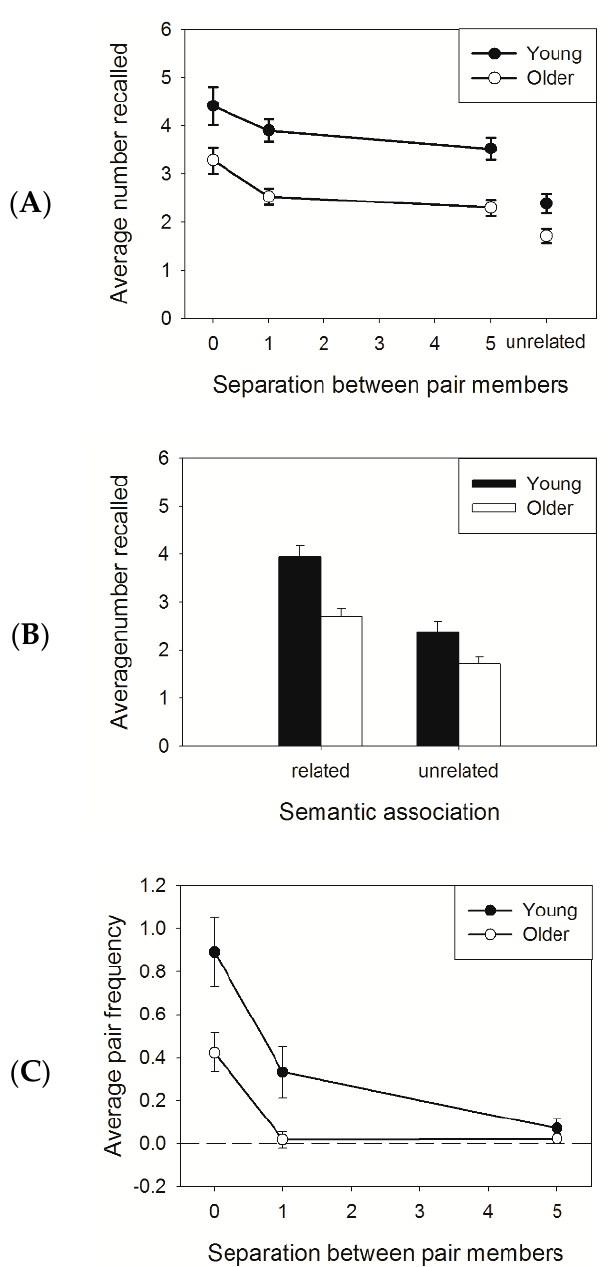
Figure 1. ( A ) Average number of words recalled as a function of the separation between the members of an associated pair and age. The separations in the related condition are presented. ( B ) The same as in panel A, but the related condition is averaged across separations. ( C ) Clustering scores in the related conditions as a function of the separation between pair members and age. The error bars represent standard error of the mean.